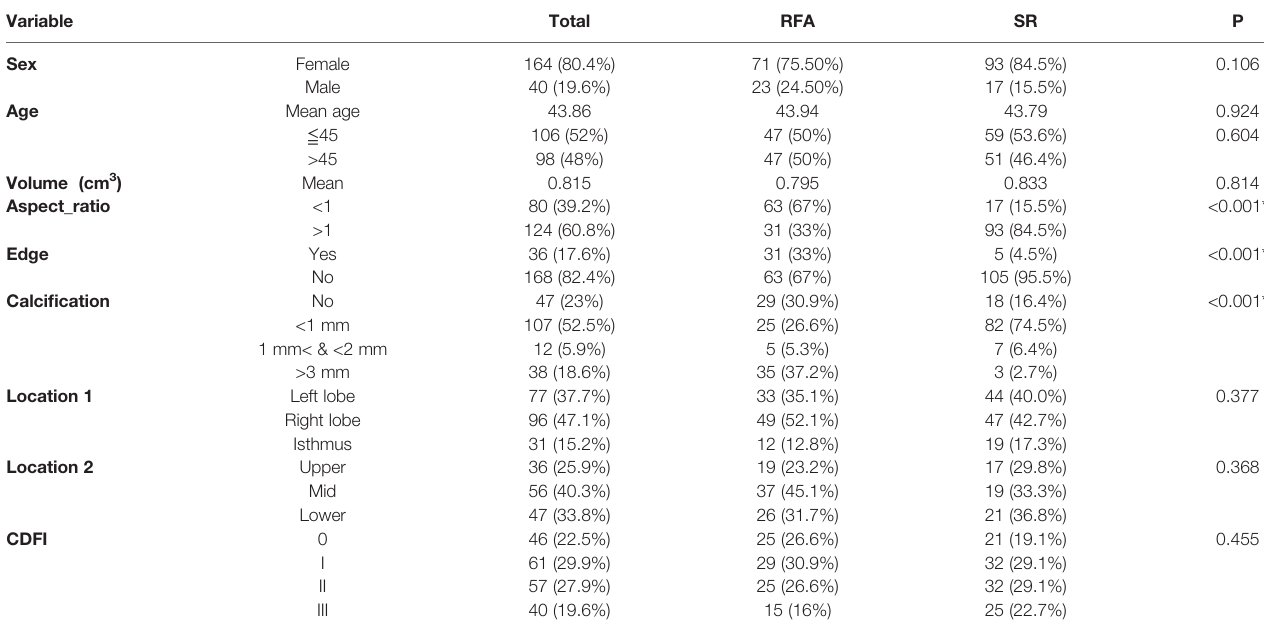
TABLE 1 | Baseline